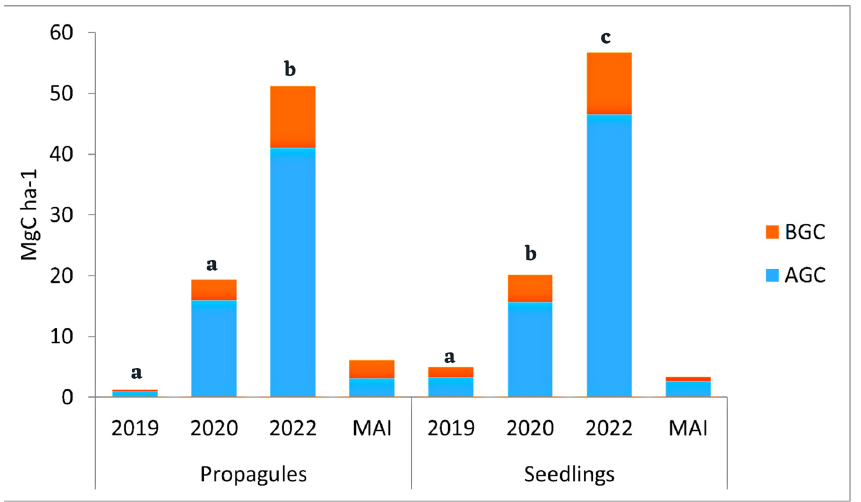
Figure 4. Above-ground (AGC) and below-ground biomass carbon (BGC) stocks stored and mean annual increment (MAI) in rehabilitated land planted with propagules and seedlings. The different letter notation shows significant differences in the Tukey at p < 0.05.